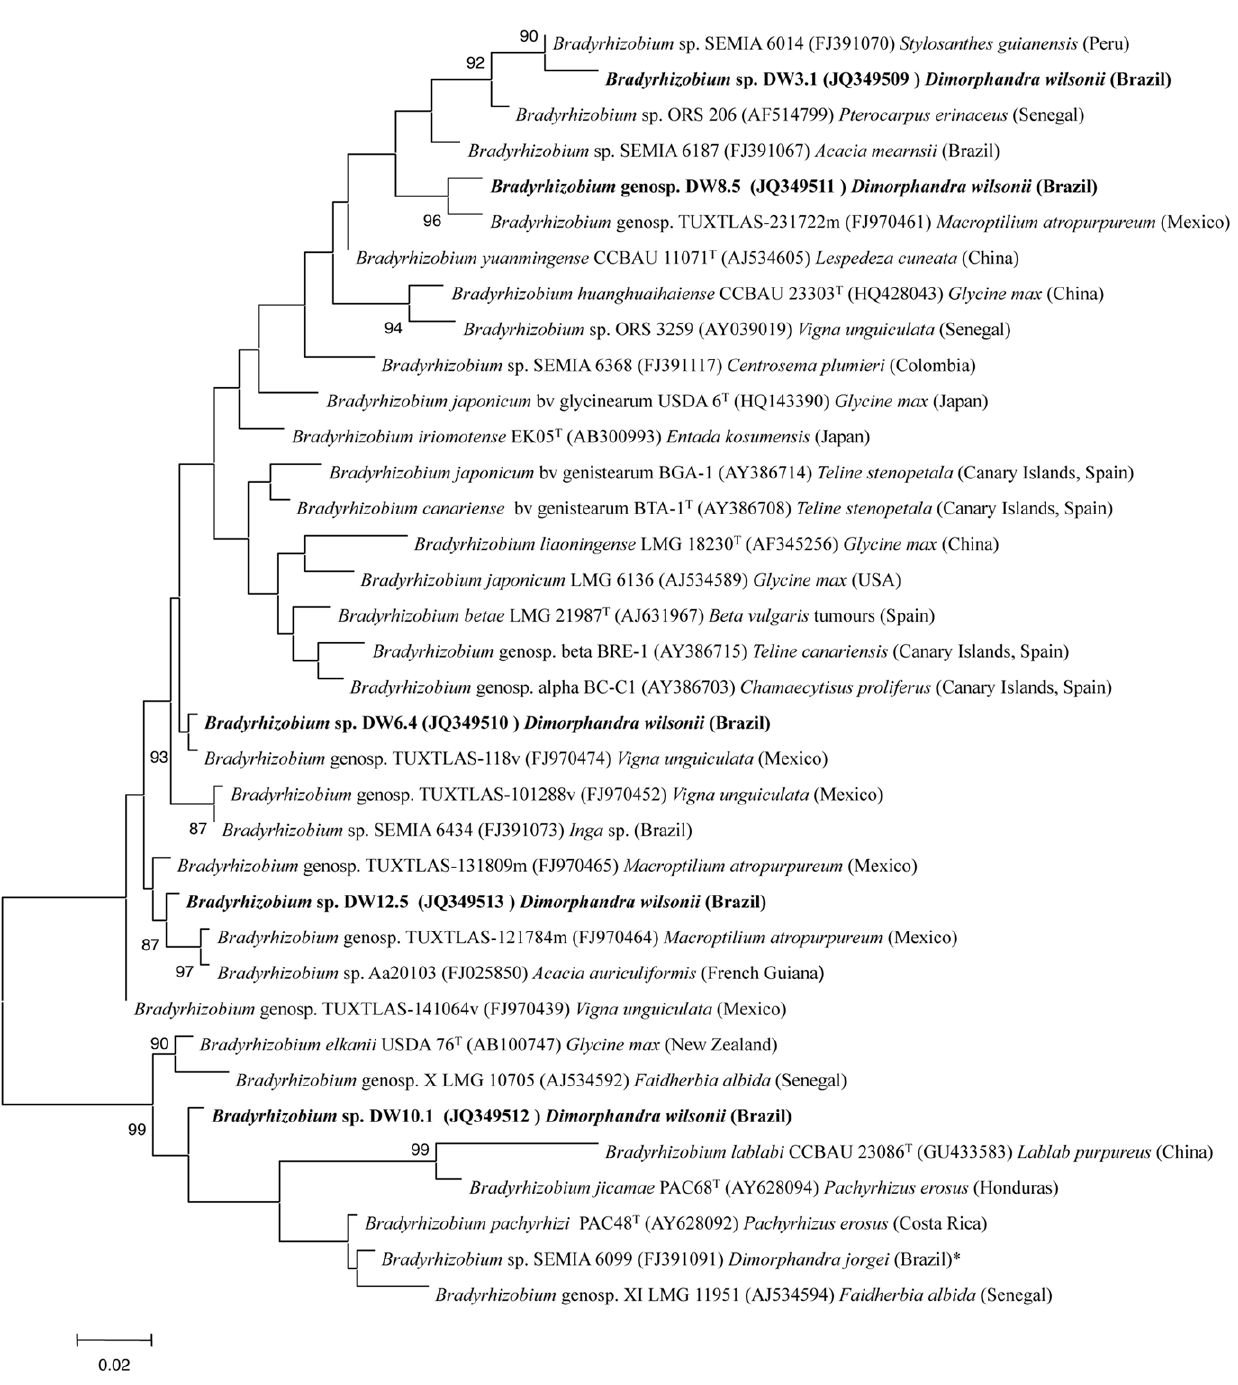
Figure 7. Maximum likelihood phylogenetic tree based on 16S-23S rDNA intergenic spacer (ITS) sequences (604 nt) showing the position of strains isolated from Dimorphandrawilsonii nodules within the genus Bradyrhizobium . Bootstrap values were calculated for 1000 replications. Bar, 1 nt substitution per 100 nt.